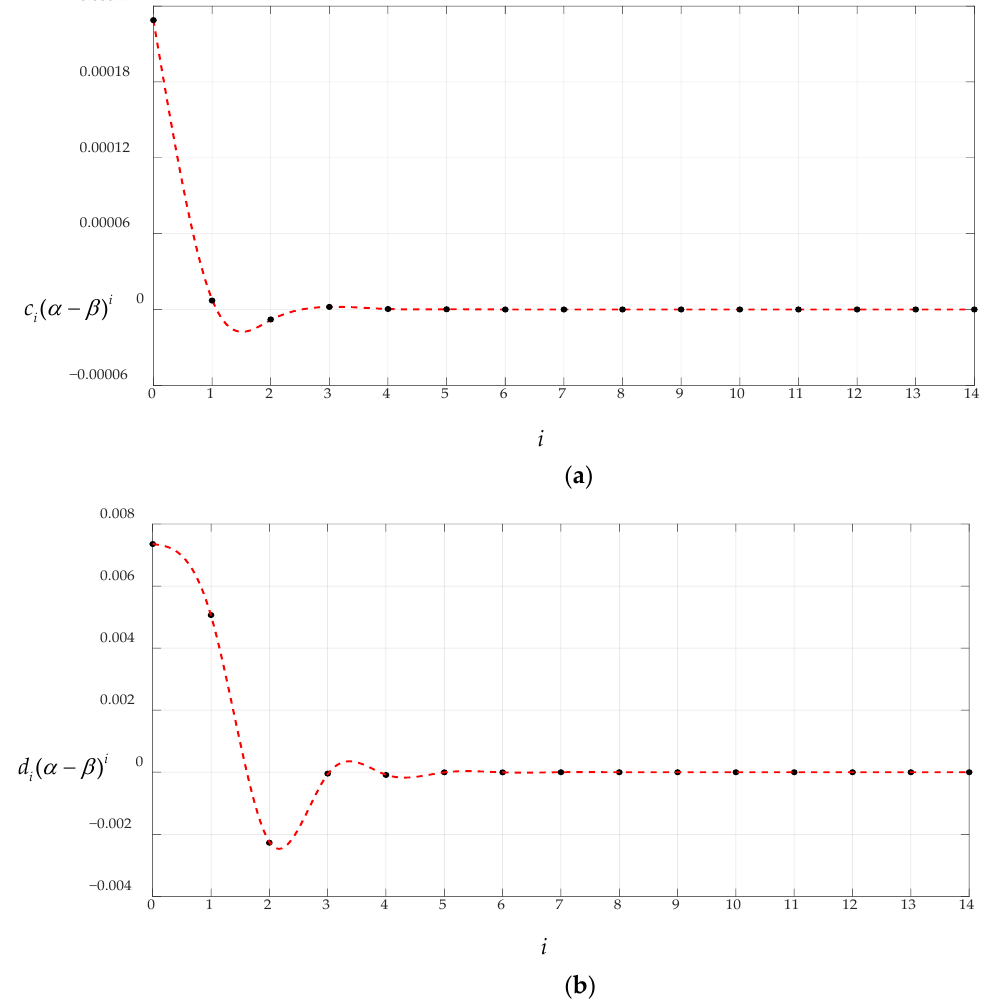
Figure 7. The variations of c i ( α − β ) i and d i ( α − β ) i with terms i , where q = 1.725 × 10 −6 MPa: ( a ) the variation of c i ( α − β ) i with i , and ( b ) the variation of d i ( α − β ) i with i .